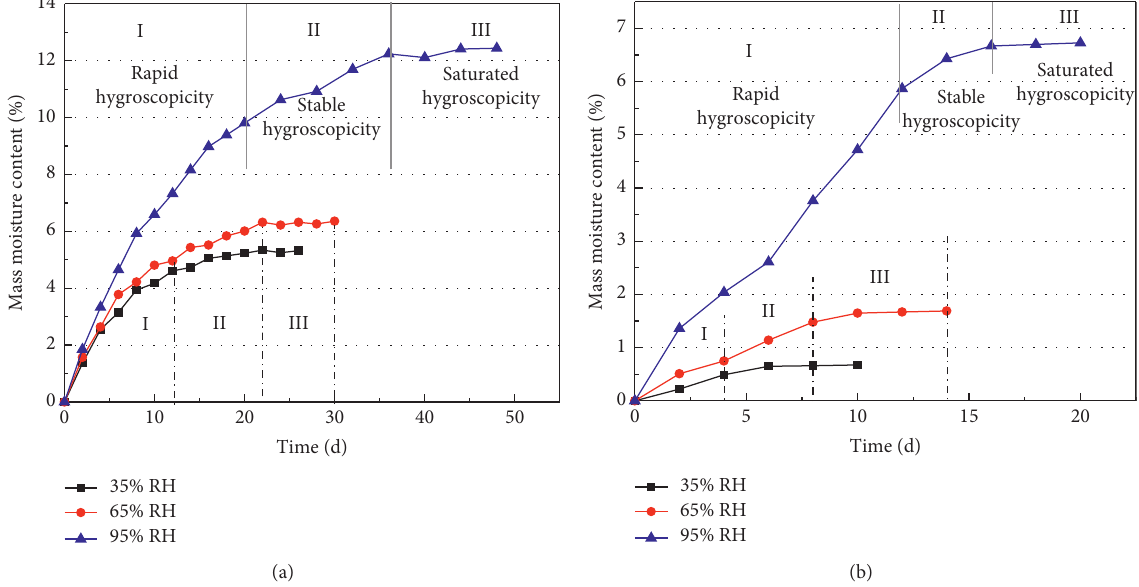
Figure 6: Relationship of the moisture content with respect to the mass percentage (%) and time. (a) Polyphenolic (b)